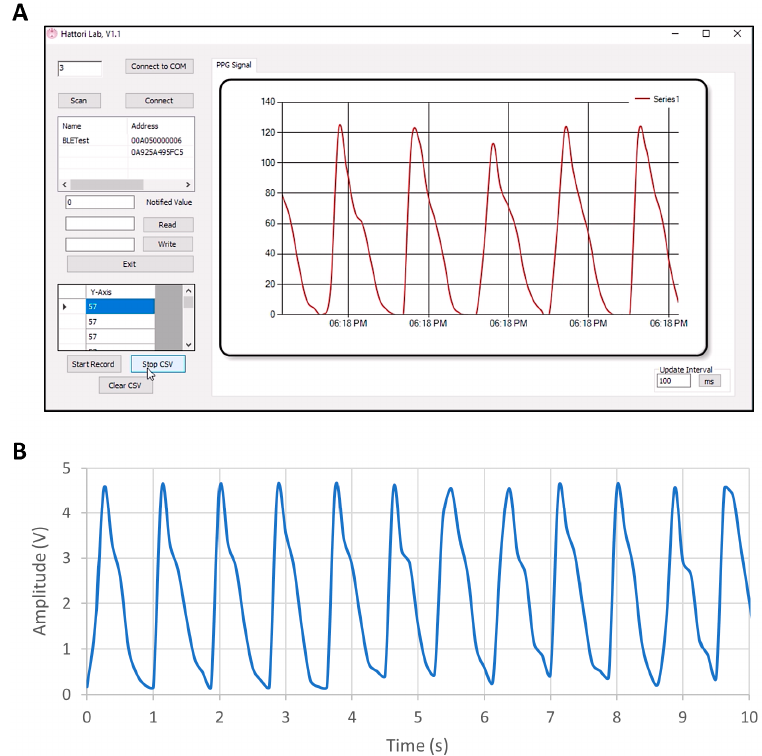
Figure 11. ( A ) The C# program shows PPG signal obtained from a universal serial bus (USB) dongle that was connected to the portable pulse meter via BLE. ( B ) PPG waveform after being recorded from the program as a comma-separated values (CSV)